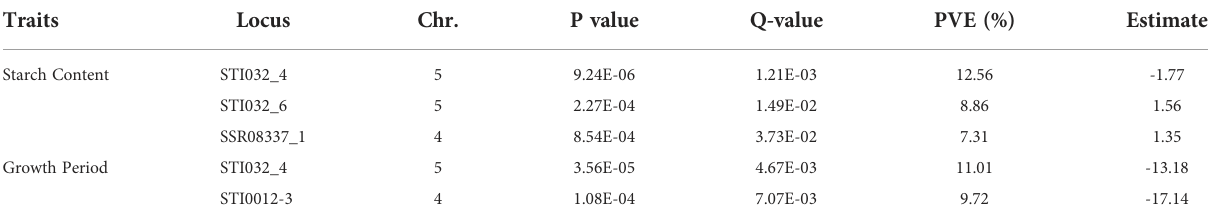
Traits Locus Chr. P